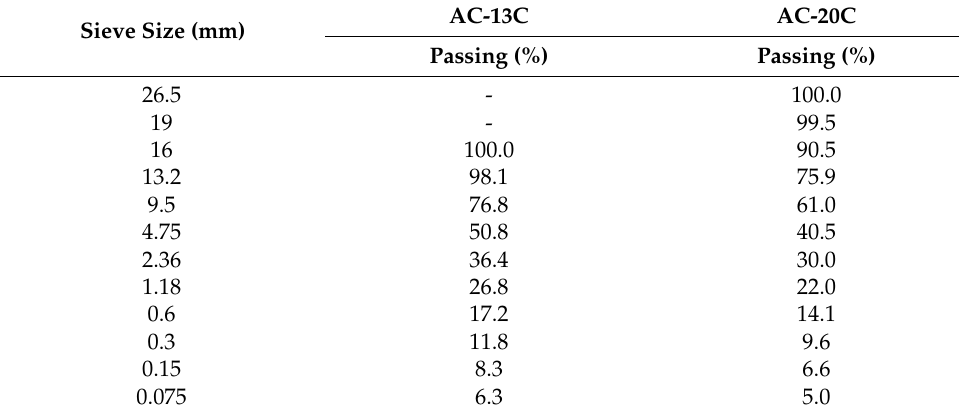
Table 3. Mineral aggregate gradation of asphalt mixture.